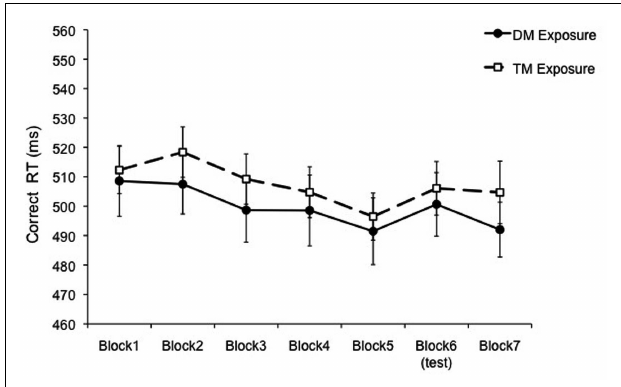
FIGURE 2 | Mean correct RT for Experiment 1 presented as a function of block separated by exposure group (Duple Meter orTriple Meter). The test block was Duple Meter. Error bars represent the standard error of the